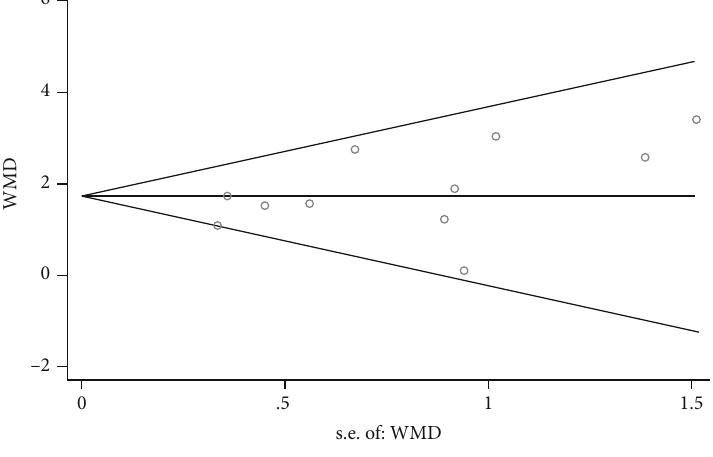
Figure 8: Begg ’ s funnel plot.